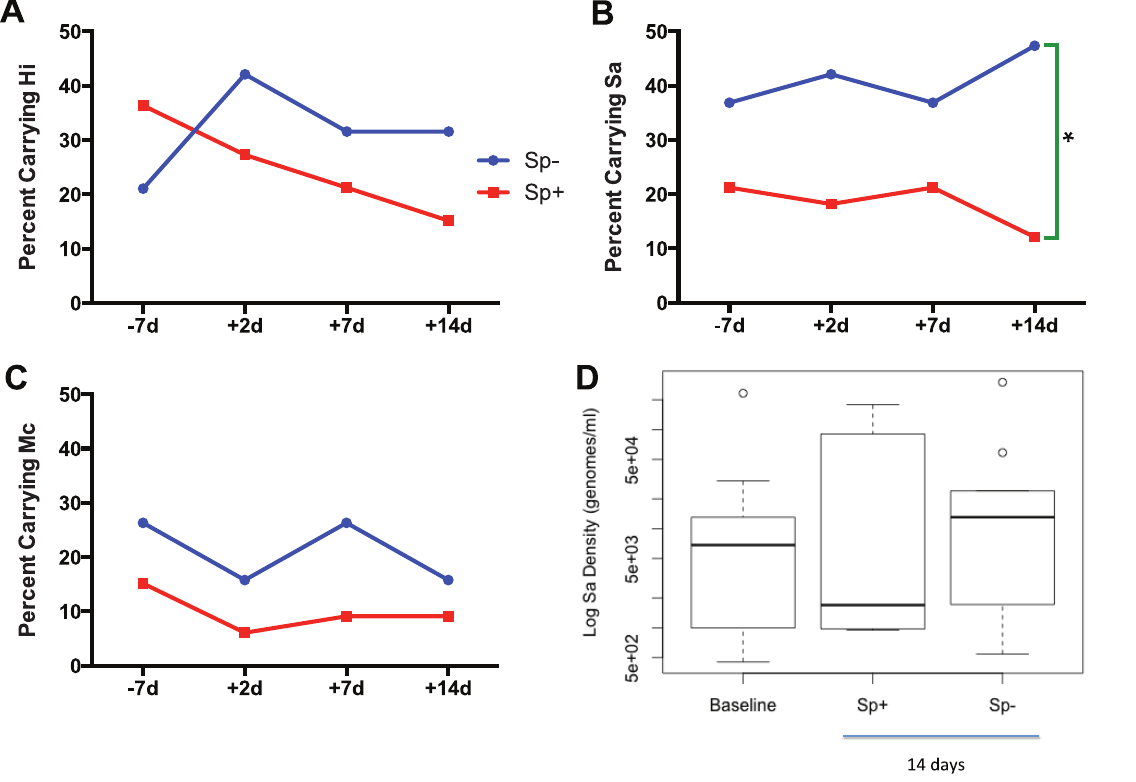
Figure 4. Percent carrying Hi (A), Sa (B), and Mc (C) at 4 time points and density of Sa colonization at baseline and 14 days (D) segregated by success of pneumococcal colonization. Numbers of subjects carrying each bacteria ranged from 11 – 17 for H. influenzae , 5 – 10 for M. catarrhalis , and 13 – 14 for S. aureus . Asterisk indicates p =0.008. doi:10.1371/journal.pone.0098829.g004 PLOS ONE |